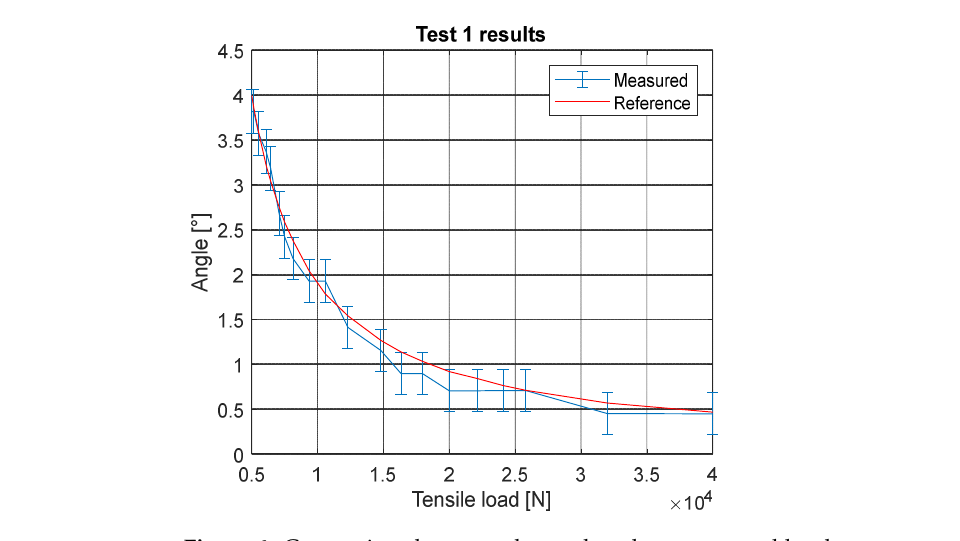
Figure 6. Comparison between the angle values measured by the sensors and the reference ones computed through catenary equation in correspondence of the sensor position during Test 1. Error bars represent the uncertainty of the sensor measurements.